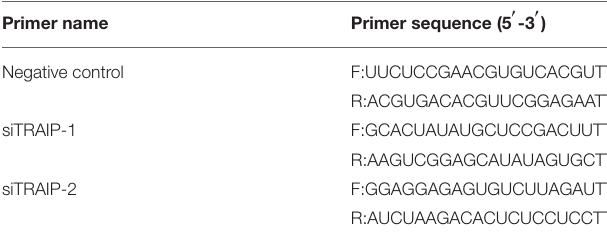
TABLE 3 | Primers used in the small RNA interfering